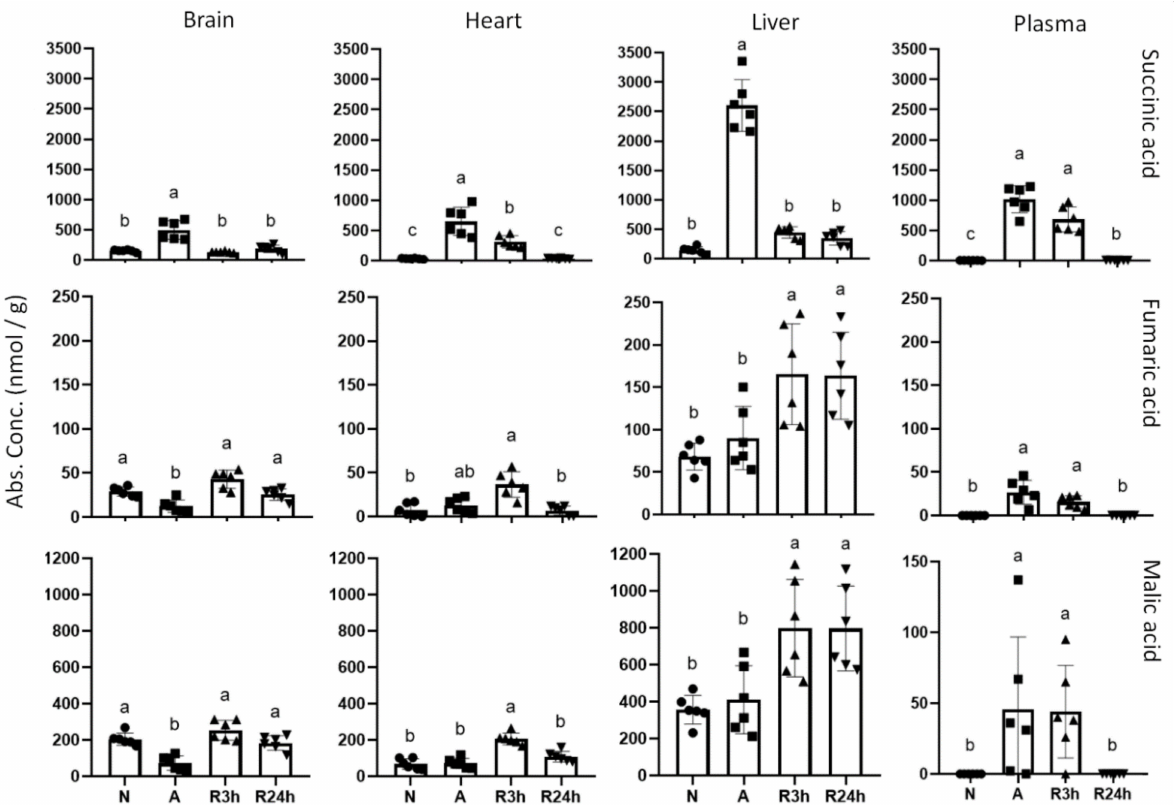
Figure 8. TCA cycle intermediates succinic acid, fumaric acid and malic acid. Graphs of absolute concentrations for succinic acid (succinate), fumaric acid (fumarate) and malic acid (malate) of brain, heart, liver, and blood plasma. N, normoxia (control); A, anoxia; R3h, 3 h reoxygenation; R24h, 24 h reoxygenation. Different letters indicate statistical differences between groups calculated using one-way ANOVA with Tukey’s post-hoc ( p -value ≤ 0.05). Note that y-axis values are different. Data are presented as means ± S.D. Values as reported by